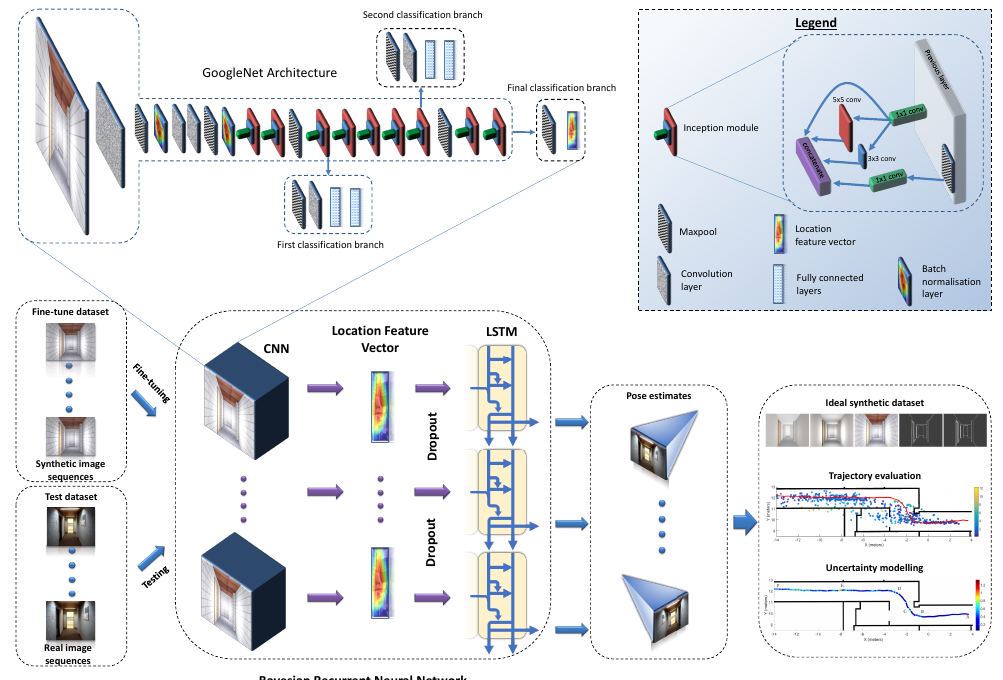
Figure 1. The design of the proposed approach. The network used is GoogleNet [22] containing nine inception modules. The output of the final classification branch yields the location feature vector which serves as input to the LSTM